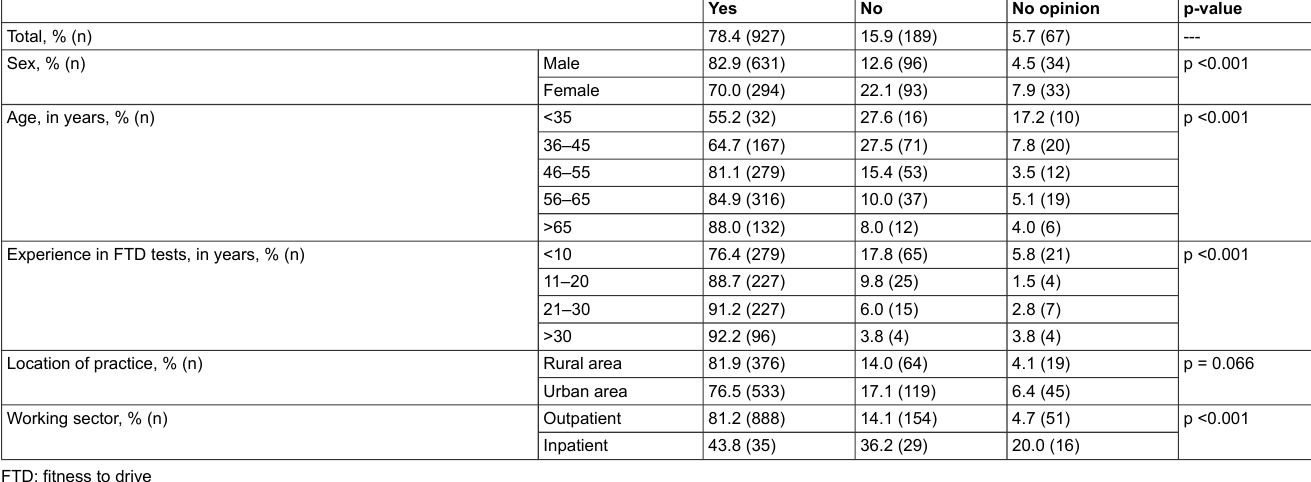
Table 4: Should family doctors perform level 1 examinations on their own